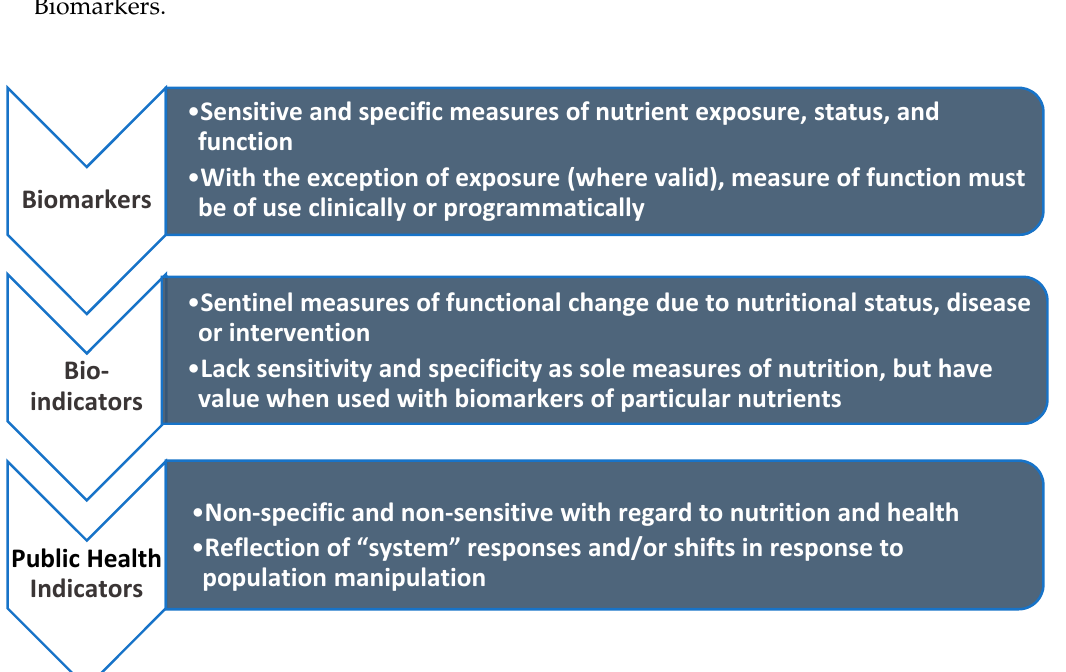
Figure 3. Tools for defining malnutrition (from Raiten and Combs) [43].